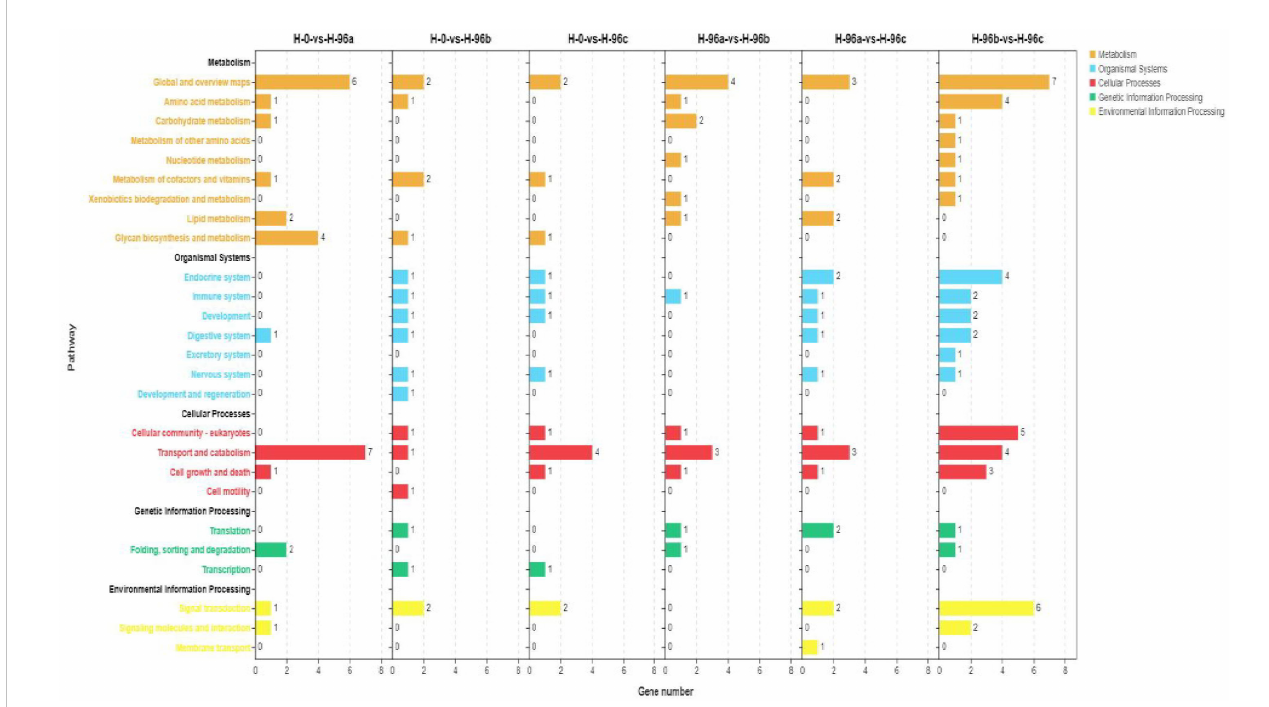
FIGURE 7 KEGG enrichment analyses of differentially expressed genes (DEGs) in hemolymph transcriptome. H-0: Control group; H-96a: concentration of 20 mg/L group; H-96b: concentration of 50 mg/L group; H-96c: concentration of 100 mg/L group.